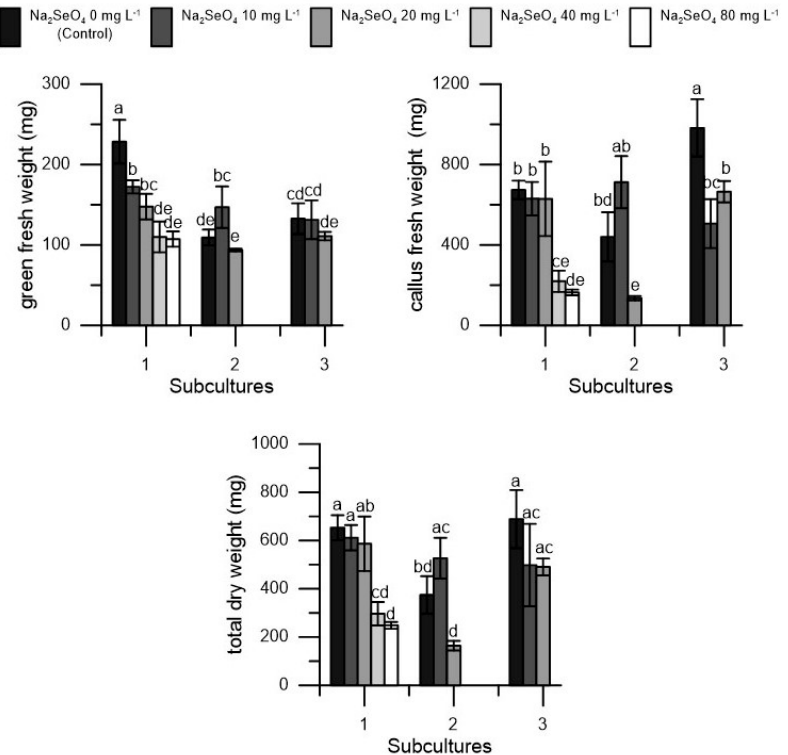
Figure 3. Green fresh weight (mg), callus fresh weight, and total dry weight (mg) in ‘Frantoio’ cv. in three different subcultures (1, 2, and 3) at five dosages of Na 2 SeO 4 (0, 10, 20, 40 and 80 mg L − 1 ) during the first subculture and at three dosages of Na 2 SeO 4 (0, 10 and 20 mg L − 1 ) during the second and third subculture. Each value represents the average of three replicates ± SEM. Mean values followed by different letters were significantly different ( p < 0.05).